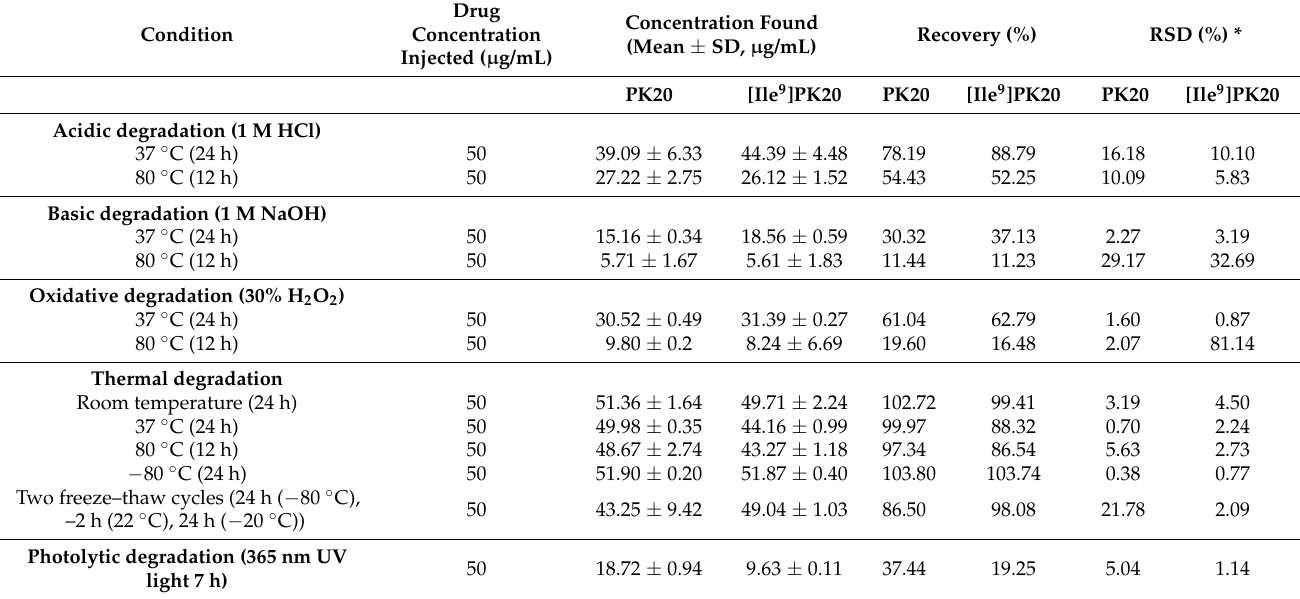
Table 1. Summarized results obtained for the chemical degradation of PK20 and [Ile 9 ]PK20 opioid– neurotensin hybrid